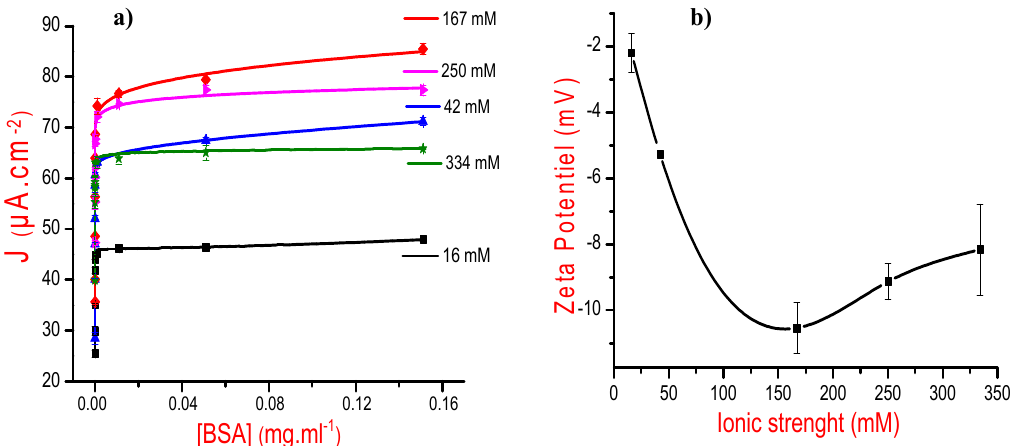
Figure 5. ( a ) Current density variations versus cumulative BSA concentrations for the four investigated ionic strengths: 16, 7, 42, 167, 250, and 334 mM (the lines are guides for the eyes). ( b ) Variation of the zeta potential versus the ionic strength (the lines are guides for the eye).